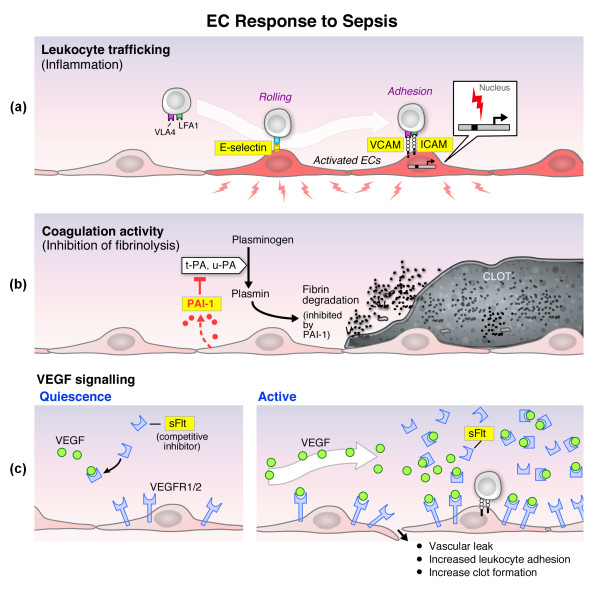
Endothelial cell response in sepsis. (a) Leukocyte trafficking. Activated endothelial cells (red-colored cells) express increased levels of E-selectin, P-selectin, intercellular adhesion molecule (ICAM)-1 and vascular cell adhesion molecule (VCAM)-1 (all but P-selectin are shown). Upregulation of E-selectin, ICAM-1 and VCAM-1 are mediated at a transcriptional level (activation signal and promoter with transcriptional start site are shown in the inset). E selectin induces rolling of circulating leukocytes. VCAM-1 and ICAM-1 induce firm adhesion of leukocytes by binding to very late antigen 4 (VLA4) and leukocyte function antigen LFA1, respectively. Following firm adhesion, leukocytes transmigrate through and/or between endothelial cells into the underlying tissue (not shown). In sepsis, E-selectin, ICAM-1, and VCAM-1 are cleaved from the cell surface and circulate as a soluble form of the receptor. Circulating levels are indirect measures of the degree of endothelial activation. (b) Hemostasis. Activated endothelial cells undergo a net shift in hemostatic balance towards the procoagulant side, leading to local clot formation. During fibrinolysis tissue-type plasminogen activator (t-PA) and urokinase-type plasminogen activator (u-PA) mediate the conversion of plasminogen to plasmin. Plasmin, in turn, proteolytically degrades fibrin. Activated endothelial cells express increased levels of plasminogen activator inhibitor (PAI-1), which inhibit the activity of t-PA and u-PA, thus accentuating the procoagulant state. (c) Vascular endothelial growth factor (VEGF) signaling. Under normal conditions (quiescence), VEGF signaling plays a critical role in homeostasis. VEGF binds to two receptors on endothelial cells, VEGF receptor (VEGFR) 1 and 2. VEGFR1 is also known as Flt-1. In sepsis (activated state), circulating levels of VEGF are increased. Elevated VEGF signaling, in turn, leads to increased vascular leak, leukocyte adhesion/trafficking, and clot formation. Sepsis is also associated with increased circulating levels of a soluble form of VEGFR1 (sFlt-1). sFlt-1 binds VEGF in the blood, thus acting as a competitive inhibitor of VEGF signaling in endothelial cells. Sepsis-mediated induction of sFlt-1 may represent a critical component of the host anti-inflammatory response.